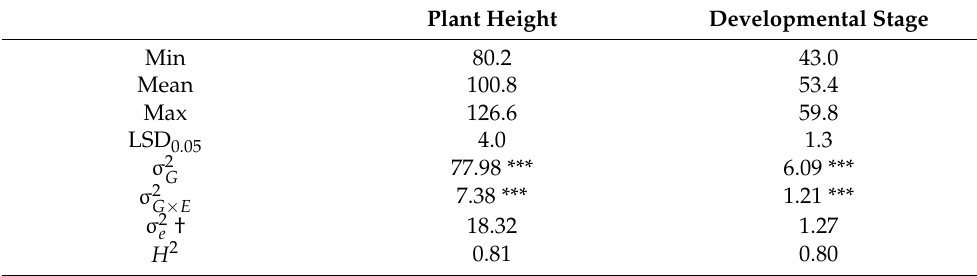
Table 1. Means and ranges of the best linear unbiased estimators as well as genotypic and genotype- by-environment interaction variance components of 846 diverse breeding lines and registered culti-